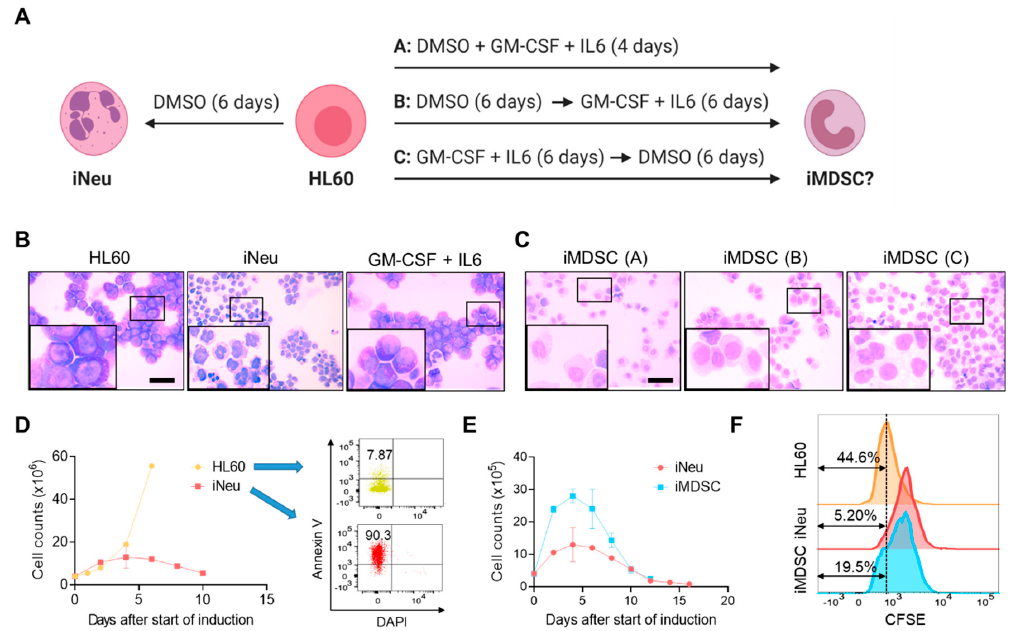
Figure 1. Induction of neutrophils and myeloid-derived suppressor cells (MDSCs) from HL60. ( A ) Experimental scheme for induced neutrophil (iNeu) and induced myeloid-derived suppressor cell (iMDSC) induction. Created with biorender.com. ( B ) Wright–Giemsa staining of HL60, iNeu, and HL60 treated with granulocyte macrophage-colony stimulating factor (GM-CSF) + interleukin 6 (IL6) for 6 days. Scale bar 50 µ m. ( C ) Wright–Giemsa staining of iMDSC induced by the three conditions shown in ( A ). Scale bar 50 µ m. ( D ) Proliferation curves and apoptosis analysis of HL60 and iNeu. Apoptotic cells were identified as Annexin V + DAPI − cells. ( E ) Proliferation curves of iNeu and iMDSC. ( F ) Representative carboxyfluorescein succinimidyl ester (CFSE) flow cytometer histograms showing the di ff erentiation dilution of the CFSE labeling of HL60, iNeu and iMDSC on Day 4 after the